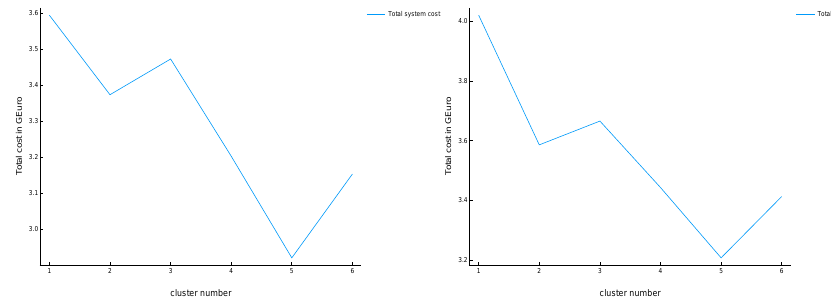
Figure 15. Total system cost for flex (left) and non-flex (right) cases. The investments into HVDC connections for both cases are the same, as depicted in Figure 16. In both cases, an HVDC submarine connection from Sicily Italy South is built. Nevertheless, in the non-flex case, the storage candidate on Sardinia is chosen by the optimiser, as otherwise the demand cannot be satisfied without significant load shedding costs.